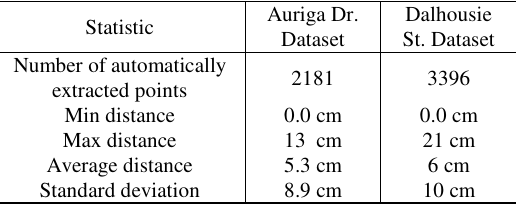
Table 1. Statistical evaluation of the extracted curb.